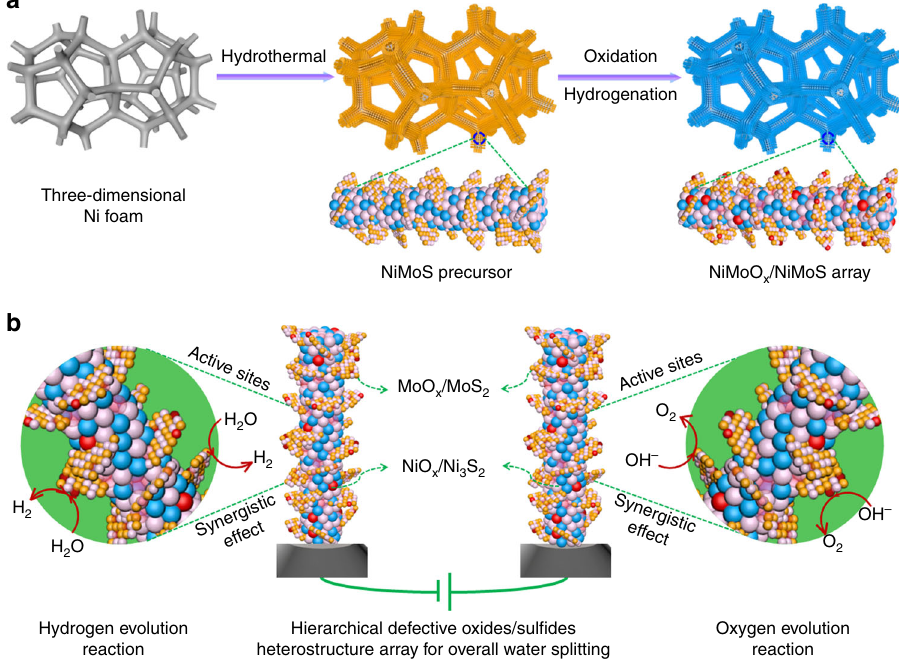
Fig. 1 Schematic representation of synthesis and overall water splitting. a Synthesis illustration of transition bimetal oxides/sul fi des heterostructure array. b NiMoO x /NiMoS array as two-electrode-cell towards large-scale electrolysis. Colored balls represent various elements (blue: Mo, pink: S, red: O, yellow: Ni).